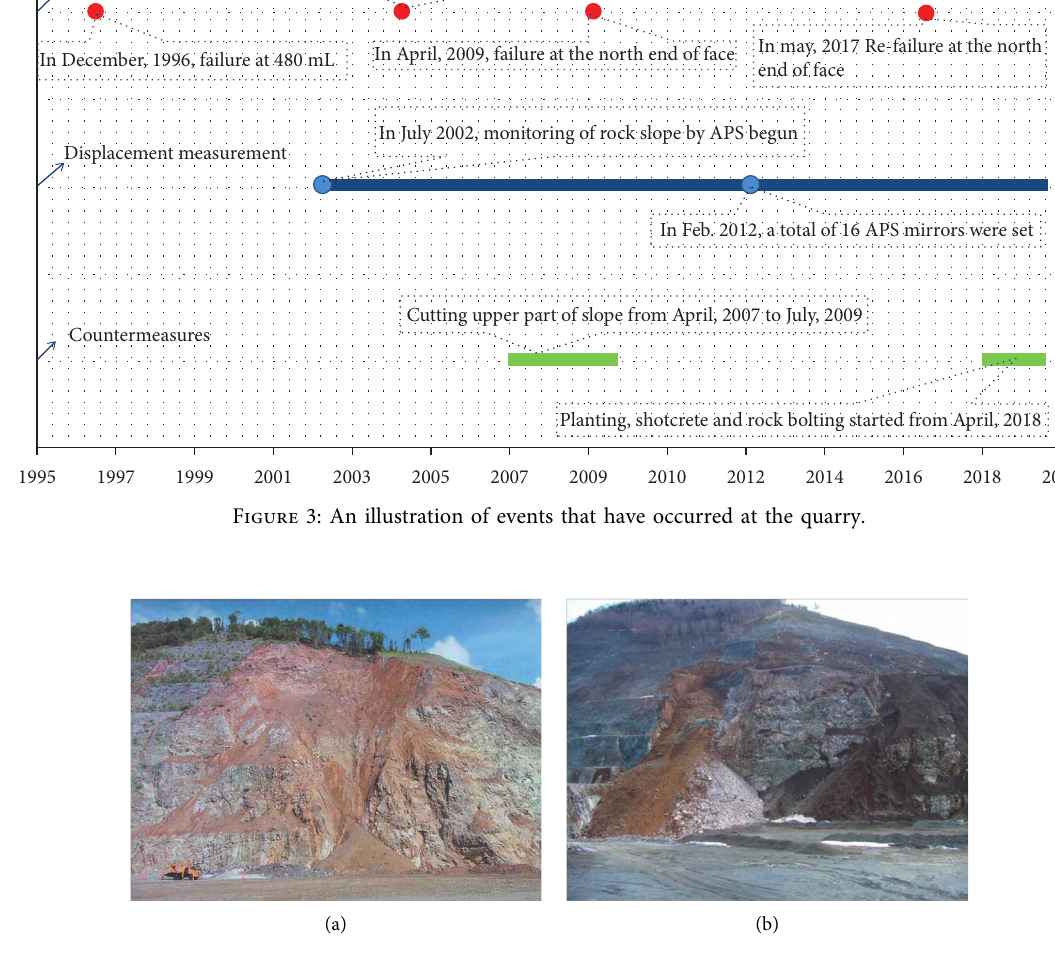
Figure 4: Slope failure that occurred at the quarry in (a) July 2004 and (b) April